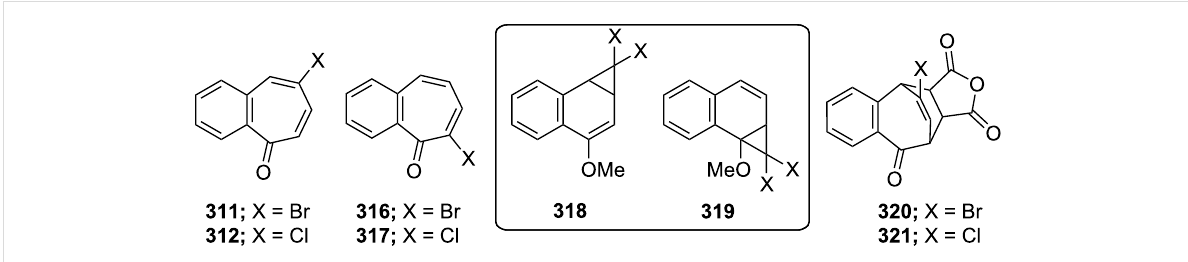
Figure 14: Some halobenzotropones and their cycloadducts.